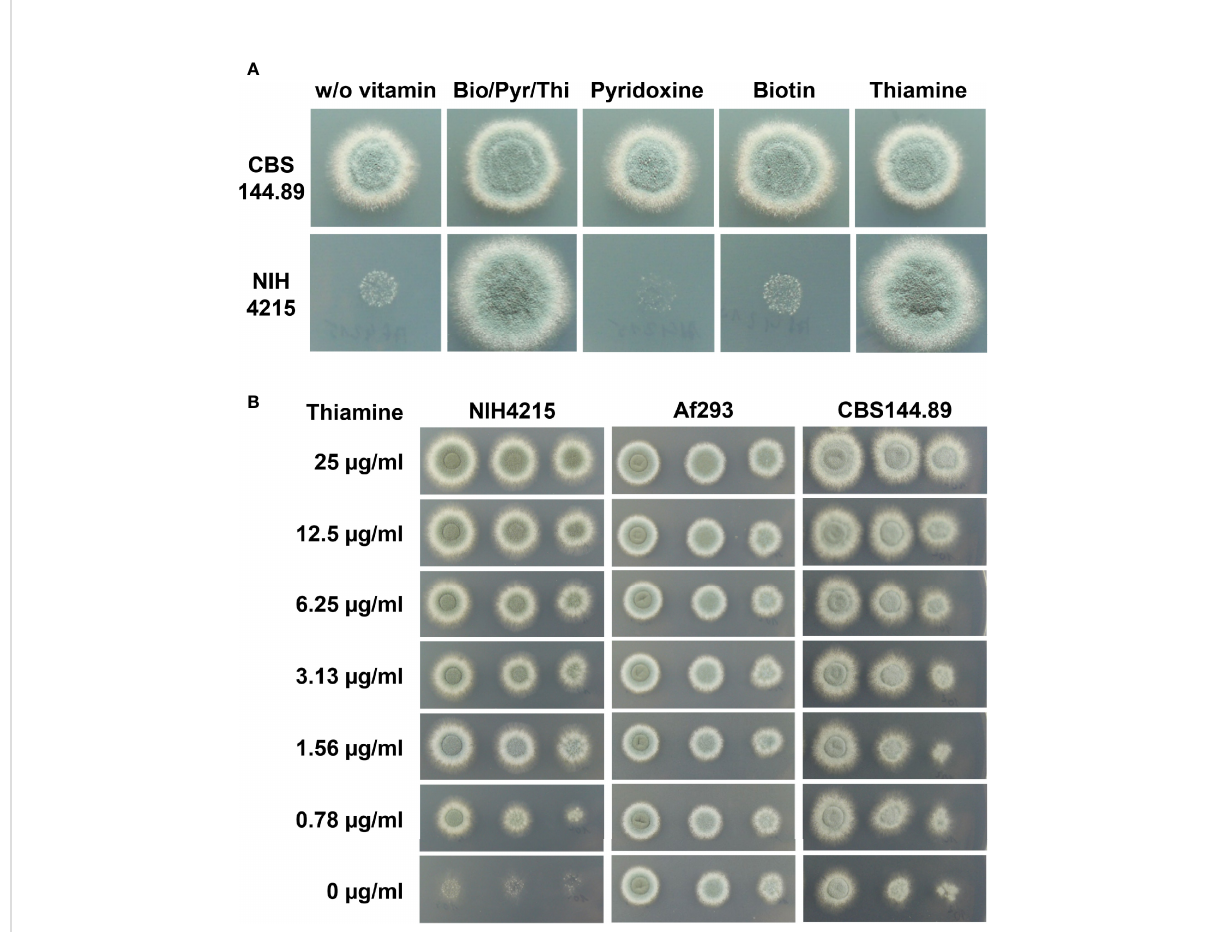
FIGURE 1 Growth of A. fumigatus strains on synthetic Aspergillus minimal media with or without vitamin supplementation. (A) 1 × 10 4 conidia of strains CBS144.89 and NIH4215 were spotted and pictures were taken after 48 h of incubation at 37°C. Bio/Pyr/Thi indicates the supplementation with the three vitamins biotin, pyridoxin and thiamine. Strain NIH4215 strictly depends on the presence of thiamine for growth. (B) Media supplementation with a serial thiamine dilution. Strain NIH4215, Af293 and CBS144.89 were tested in parallel and 10-fold serial dilutions of conidia suspensions were